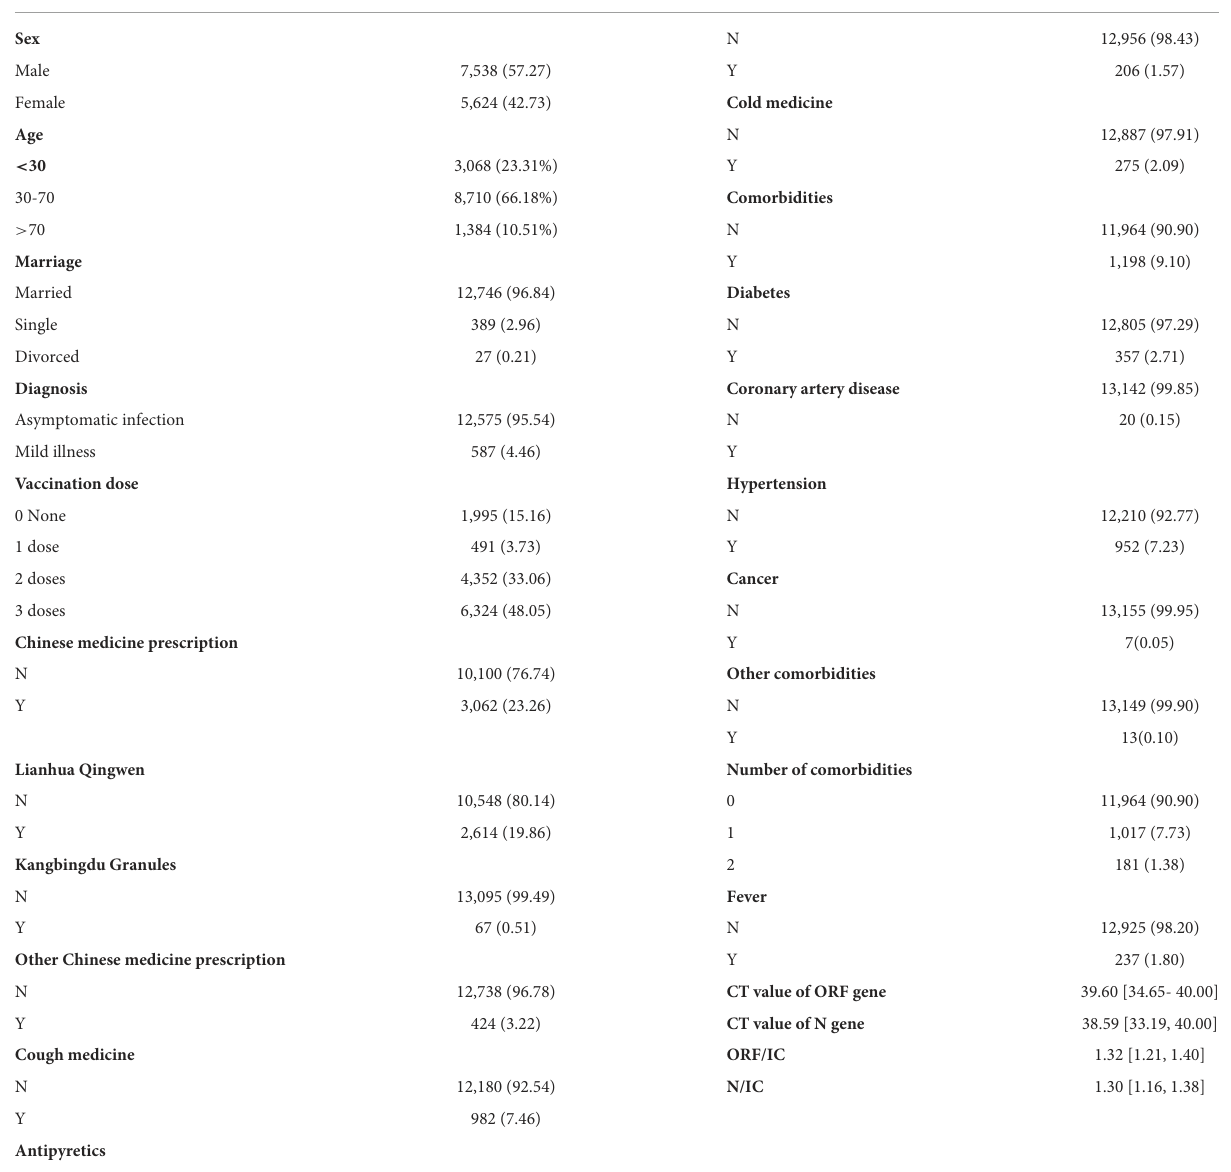
TABLE 1 Clinical characteristics of 13,162 cases of Omicron infection in